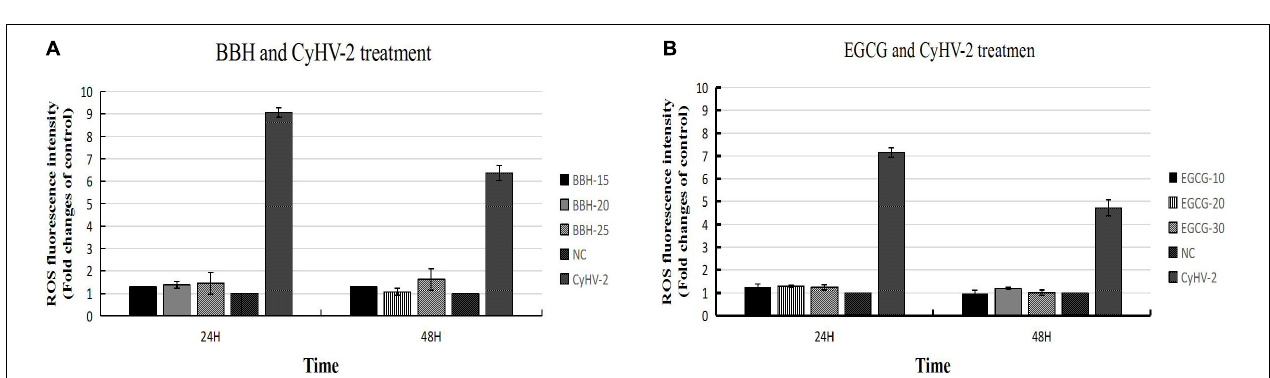
FIGURE 5 | Berberine hydrochloride (BBH) enhanced the CyHV-2-induced expression of genes of Nrf2 signaling pathway in RyuF-2 cells. Quantitative real-time RT-PCR analysis was performed to compare the transcriptional expression levels of Keap1 (A) , Nrf2 (B) , GSS (C) , CAT (D) , SOD2 (E) and viral ORF121 (F) in infected cells. The mRNA level was normalized against housekeeping gene β -actin. MOCK-infected cells treated with 20 µ g/ml BBH and CyhV-2-infected cells without BBH treatment served as controls. Similar results were obtained from three independent experiments. Data were represented as means SD.